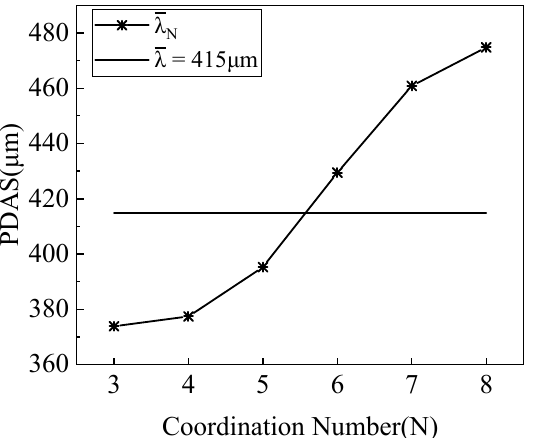
Figure 12. The relationship between the coordination number and local PDAS of HT901, λ = 415 µ m is the average local dendrite spacing determined in Figure 11a.